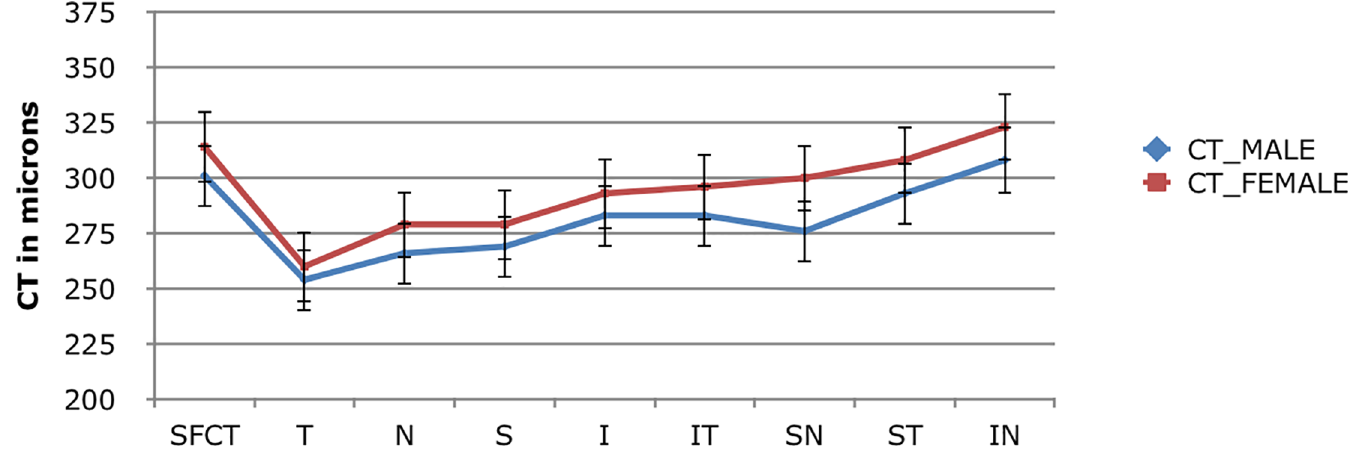
Fig 3. Graph with mean choroidal thickness with confidence interval amongst male and female